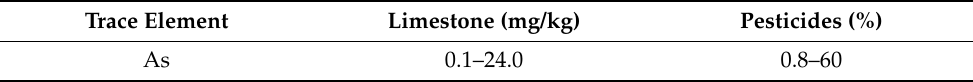
Table 4. Range of contents of As in agricultural limestone and pesticides [33].